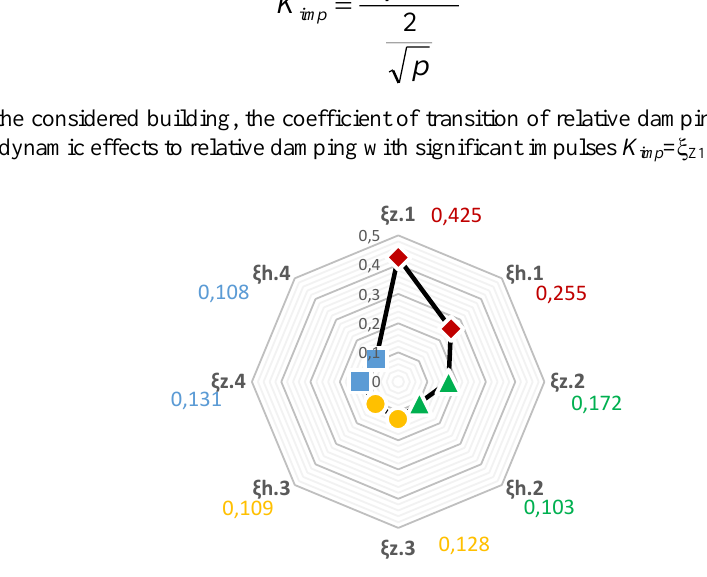
Fig. 3. The relative damping parameters calculated in accordance with SP 26.13330.2012 (1 and 2) and instrumentally measured (3 and 4) in fractions of the critical for vertical (Z) and horizontal (H) vibrations under impulse (1) and random (2) dynamic